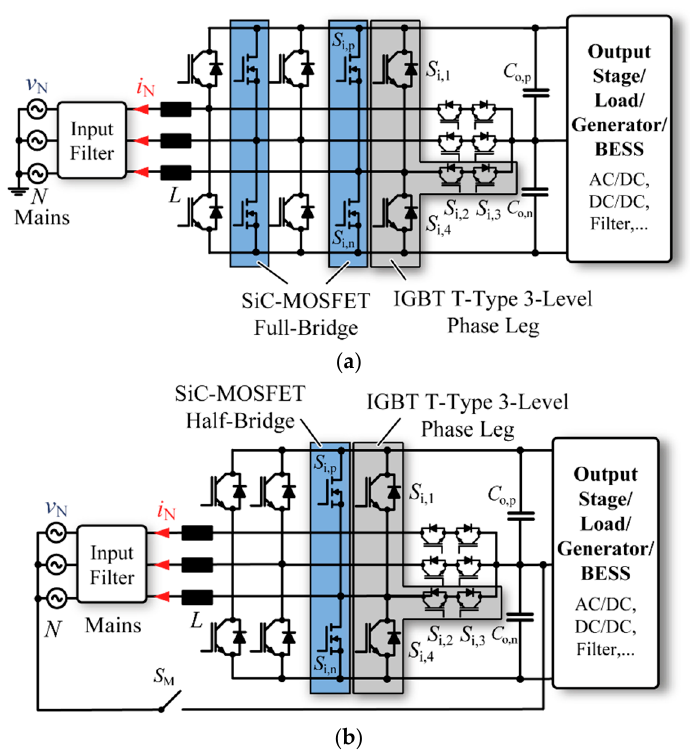
Figure 5. Grid-connected three-phase IGBT-based rectifier / inverter systems utilizing a low-cost version of the light load wide-bandgap solution by implementing merely either ( a ) 4 (two-phase operation) or ( b ) 2 (single-phase) SiC power semiconductors.